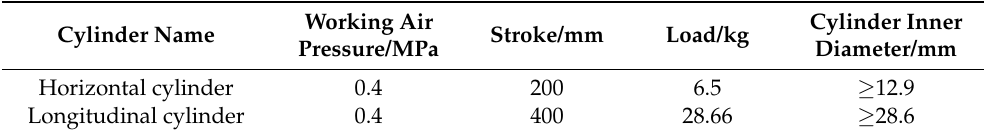
Table 1. Calculation results of cylinder inner diameter.